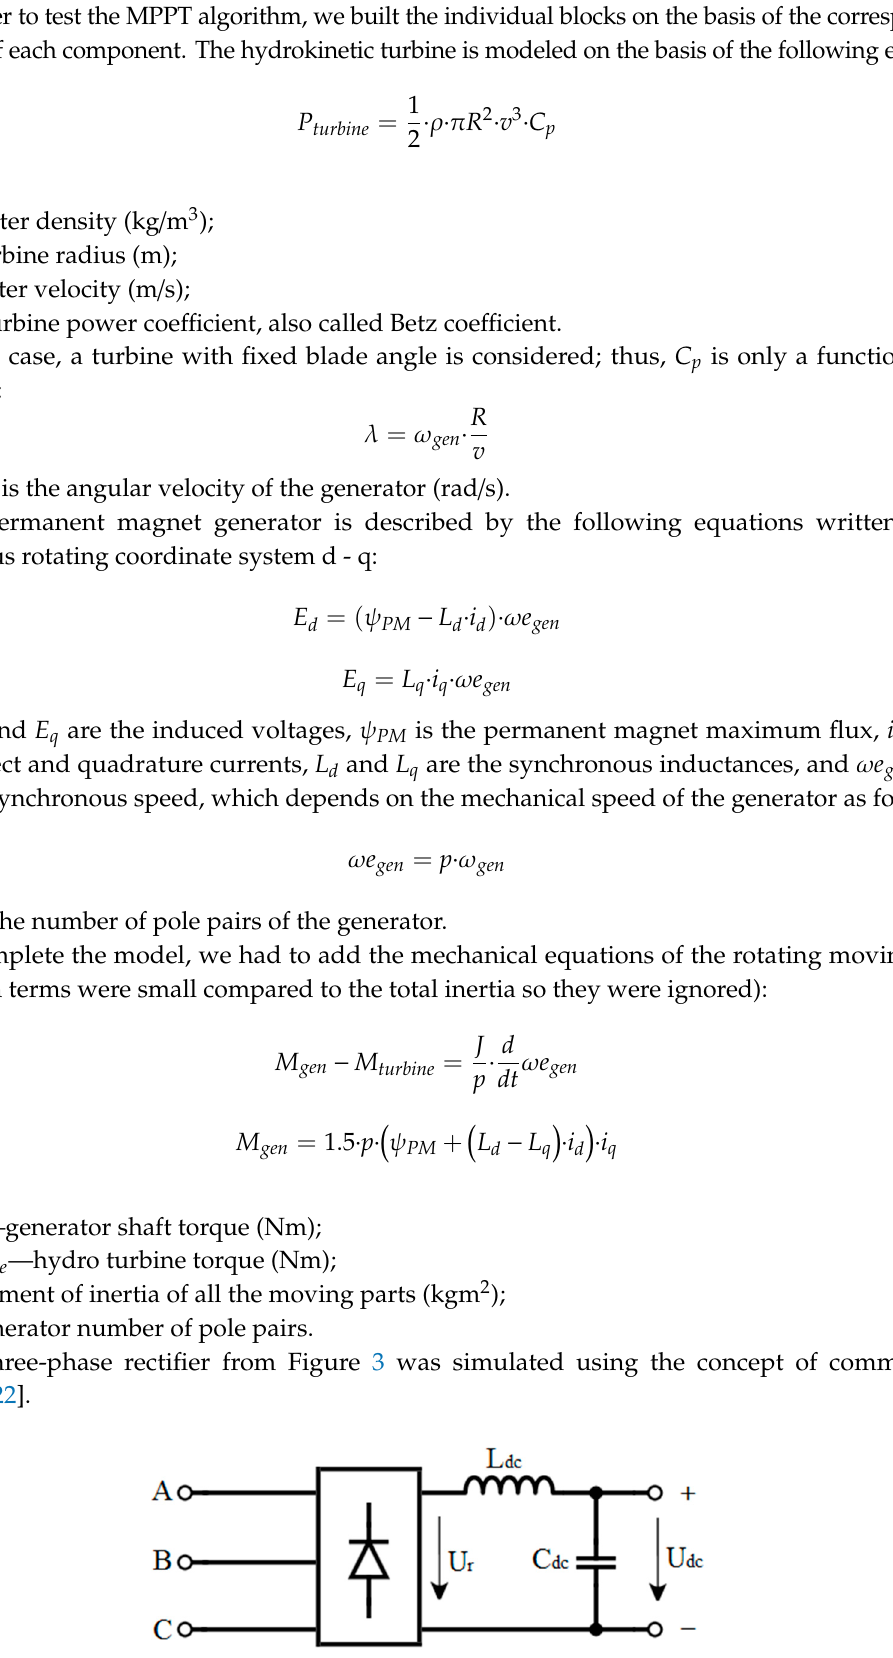
Figure 3. Three-phase rectifier.